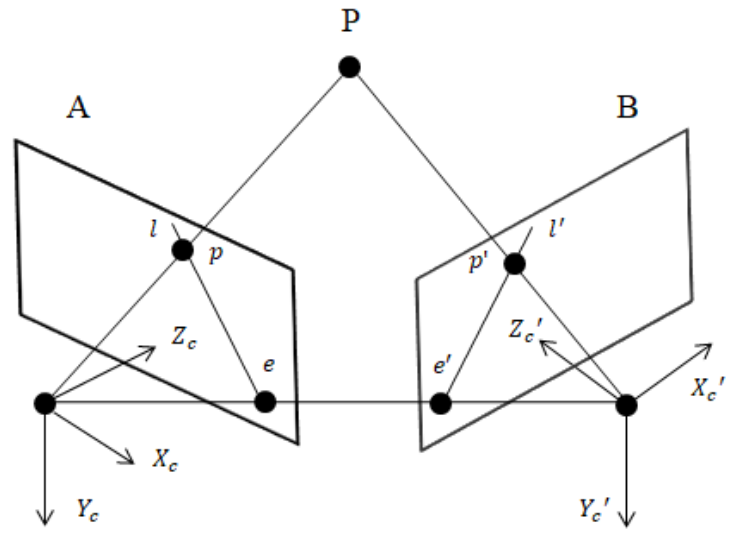
Figure 6. Epipolar